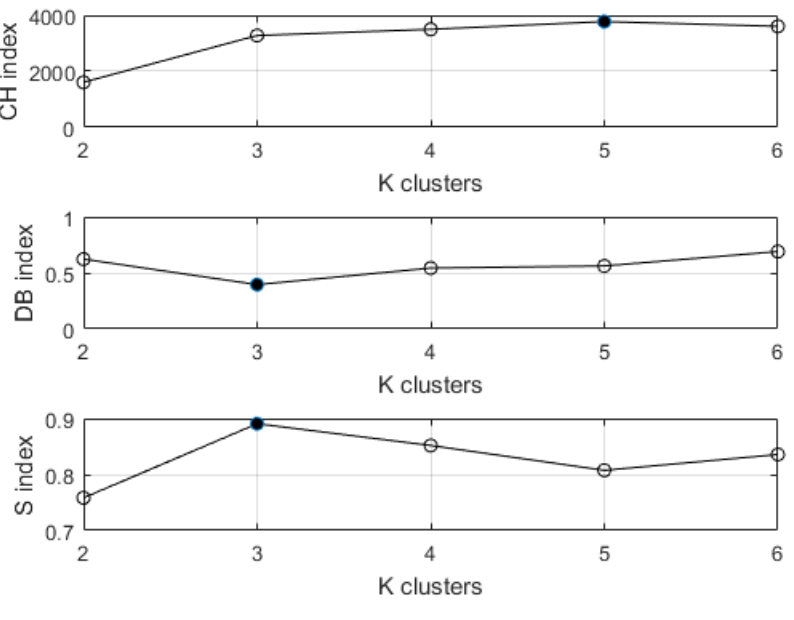
Figure 10. Internal validation indexes of the performed